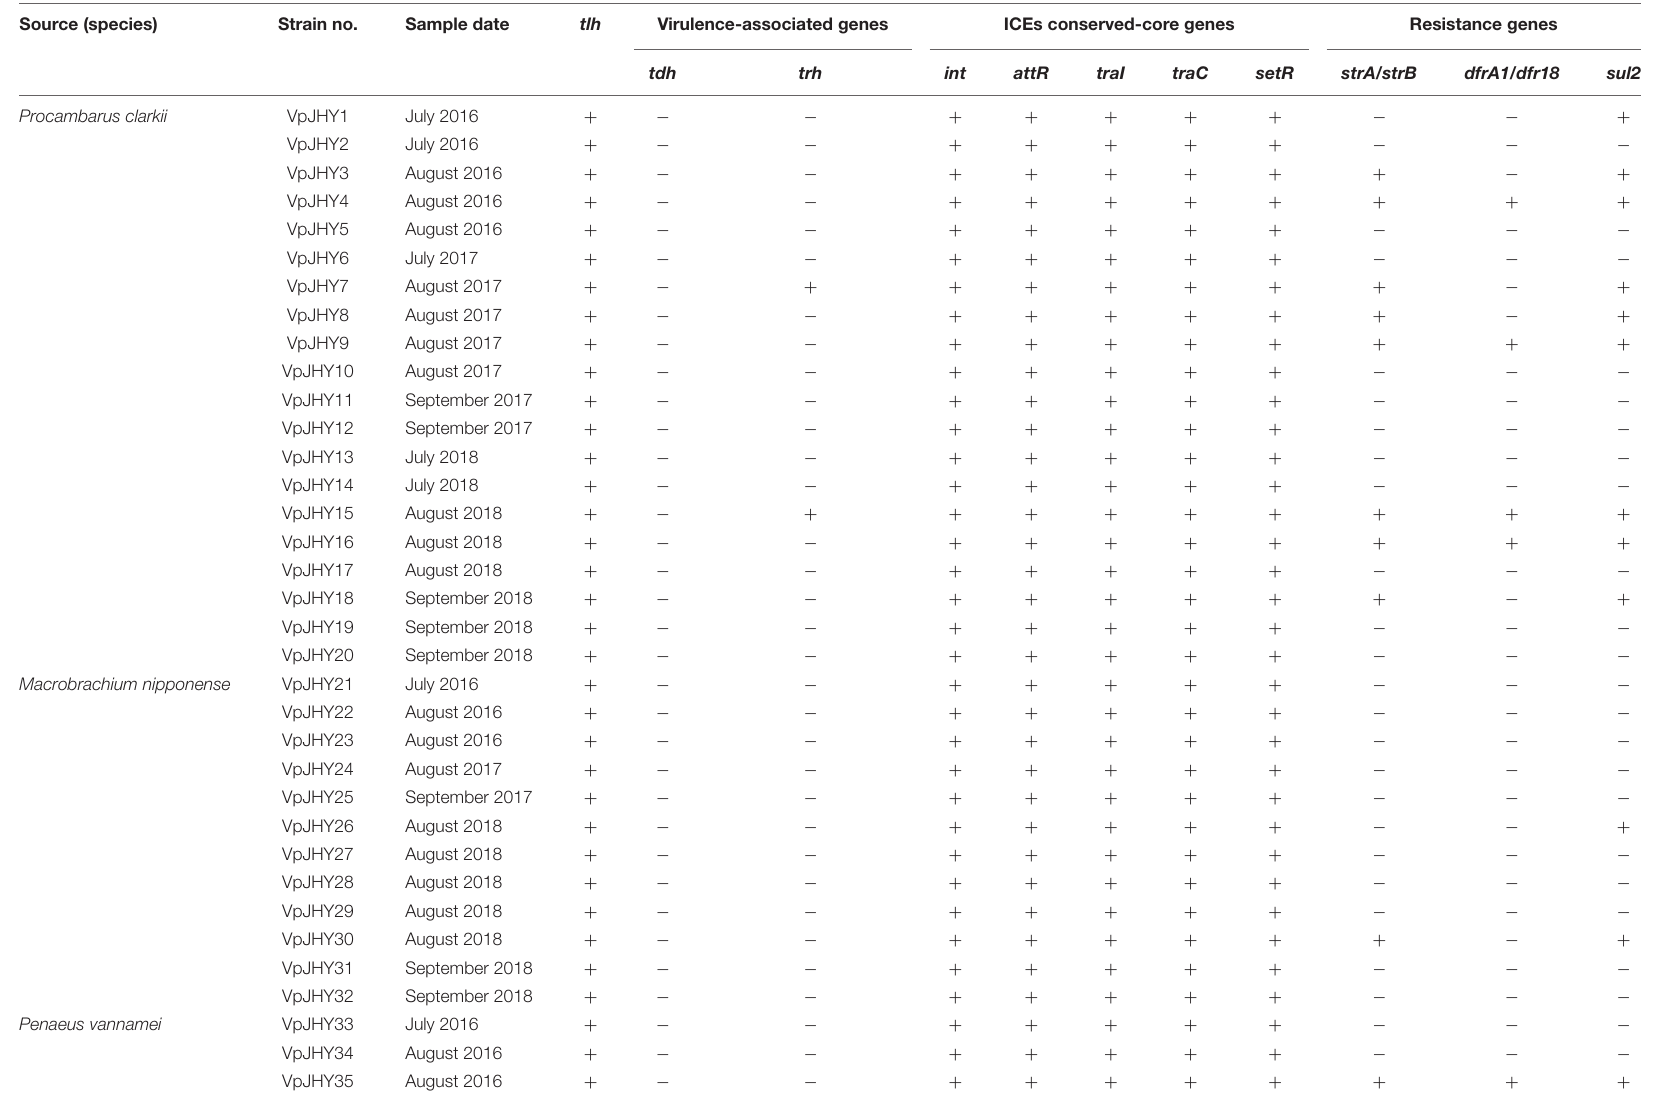
TABLE 2 | Genotypes of V. parahaemolyticus isolated from shrimp. Source (species) Strain